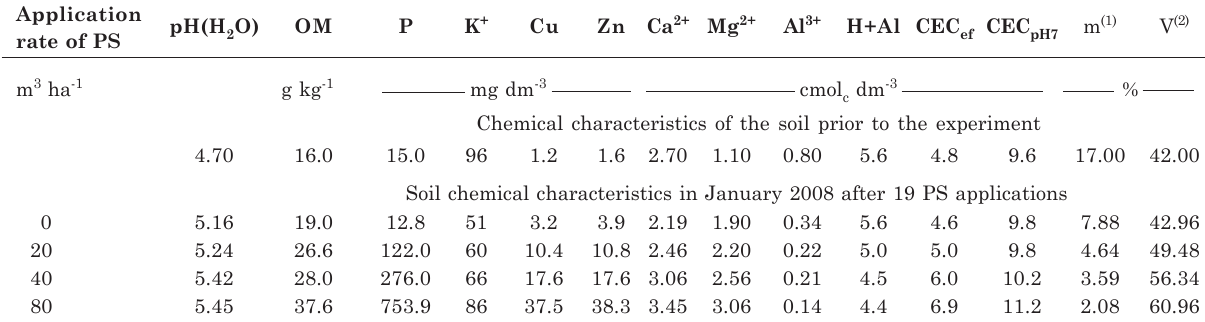
(1) Al saturation; (2) Bases